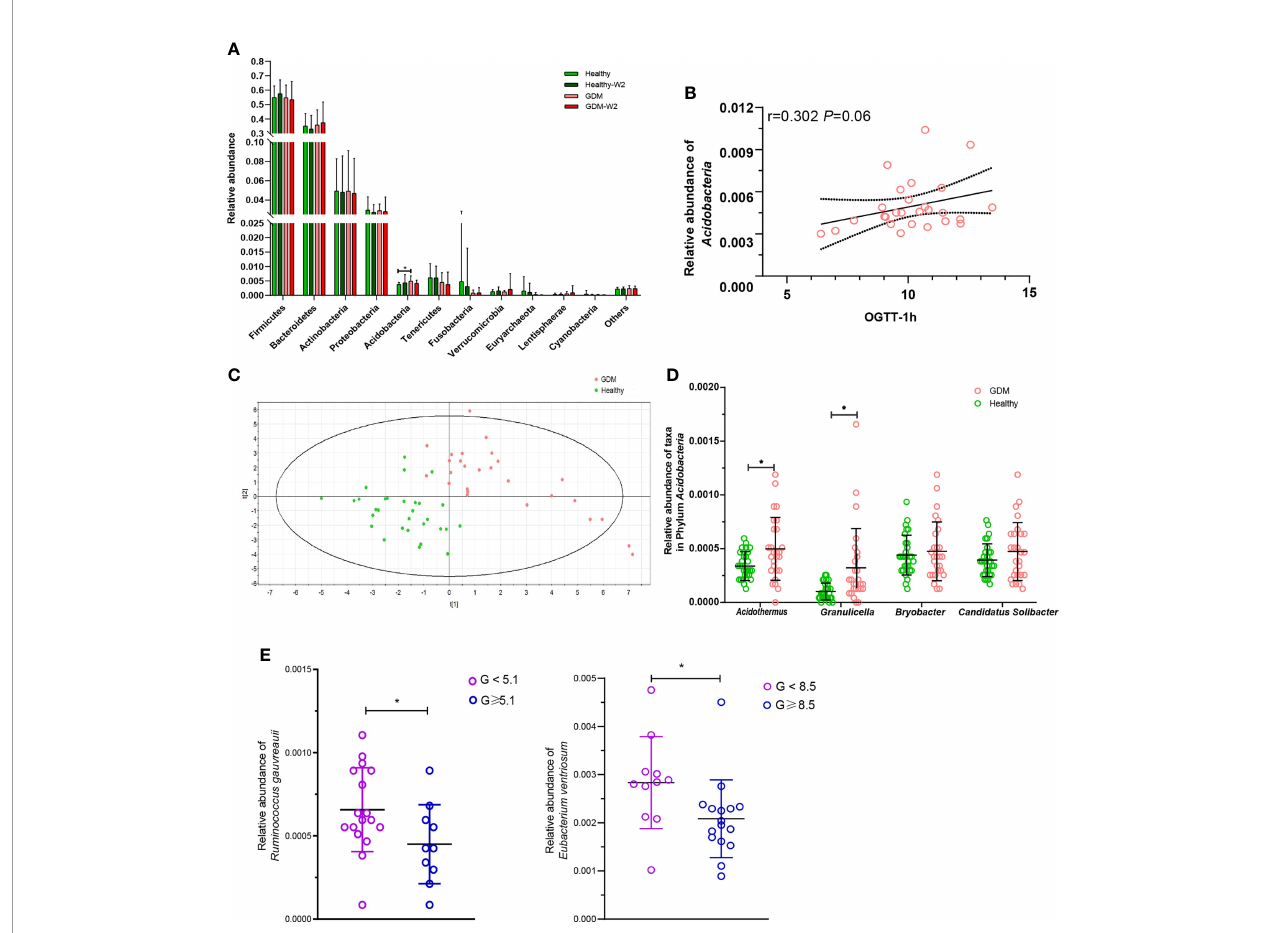
FIGURE 3 | Abundances of taxa in GDM and healthy participants. (A) Comparison of the relative abundances at the phylum level among the four GDM and non- GDM groups. The Mann – Whitney test was used to evaluate the two groups. * P <0.05. (B) PLS-DA score plots based on the relative abundances of microbiota between the GDM and healthy groups. (C) Correlation between the relative abundance of the phylum Acidobacteria and the 1-h OGTT measurement. Spearman analysis, R=0.302, P =0.06. (D) Comparison of the relative abundances of Acidothermus, Granulicella, Bryobacter , and Candidatus_Solibacter in the phylum Acidobacteria in the GDM and healthy groups. Mann-Whitney test, GDM vs. control, * P < 0.05. (E) The relative abundances of Ruminococcus gauvreauii and Eubacterium ventriosum were highly correlated with the OGTT values at 0 h and 2 h. Mann-Whitney test, GDM vs. healthy, * P <